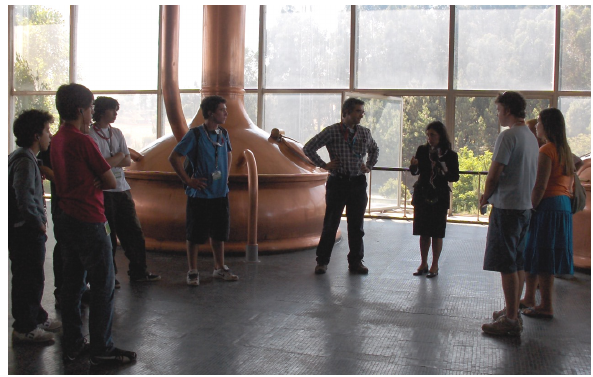
Figure 10. Visit to a brewery and a soft drinks company